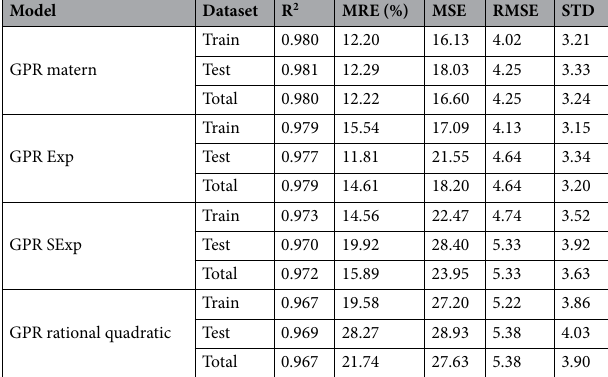
Table 1. The statistical parameters of suggested GPR models.